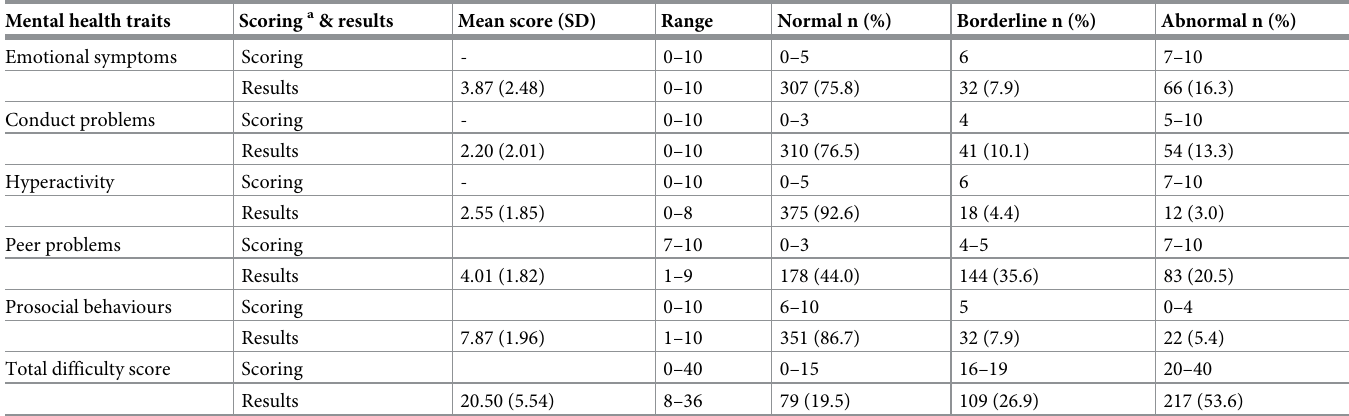
Table 2. Mean scores and distribution of mental health strengths and